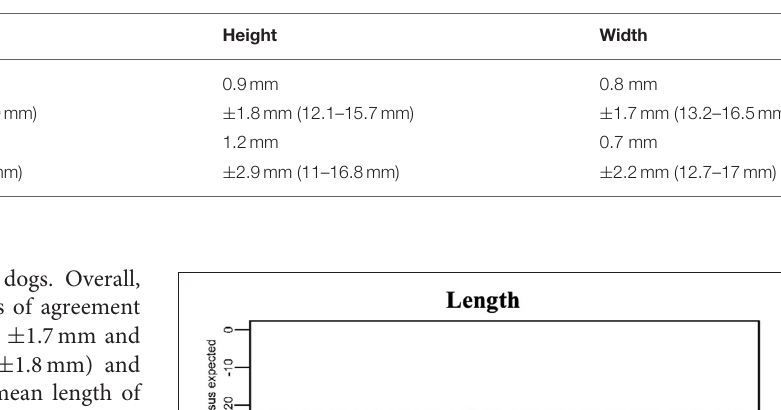
TABLE 2 | SD, standard deviation; LoA, limits of agreement; into brackets: 95% reference interval.